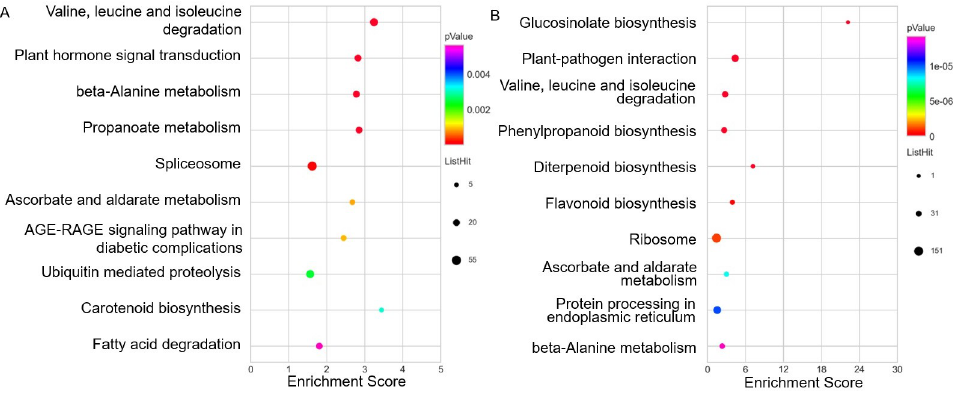
Fig 5. TOP10 KEGG enriched pathway based on DEGs annotated from plant databases. A: up-regulated DEGs; B: down-regulated DEGs.